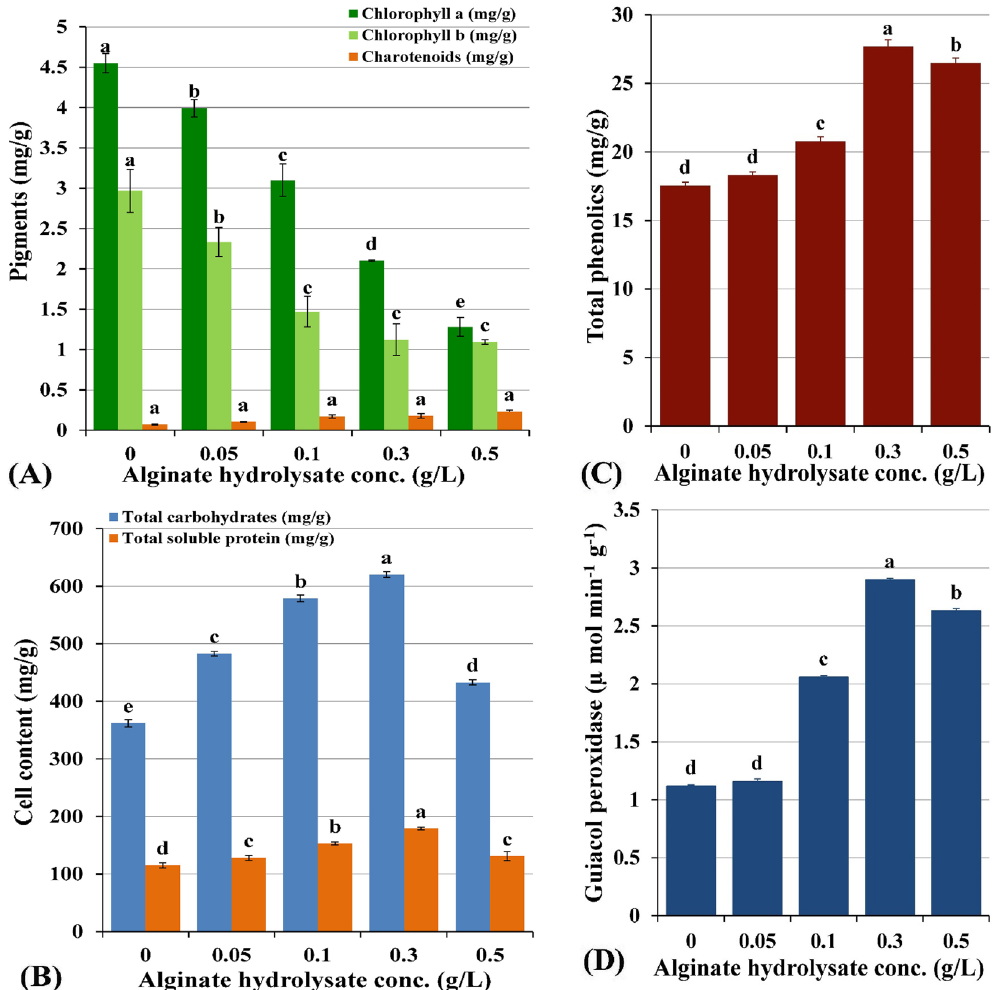
Figure 5. ( A ) Variation of C. vulgaris pigments content (mg/g dry wt.), ( B ) Variation of carbohydrates and protein content (mg/g dry wt.) with different alginate hydrolysate supplementations (g/L), ( C ) Variation of C. vulgaris phenolics content (mg/g), ( D ) guaiacol peroxidase content (µ mol min −1 g −1 ) with different alginate hydrolysate supplementations